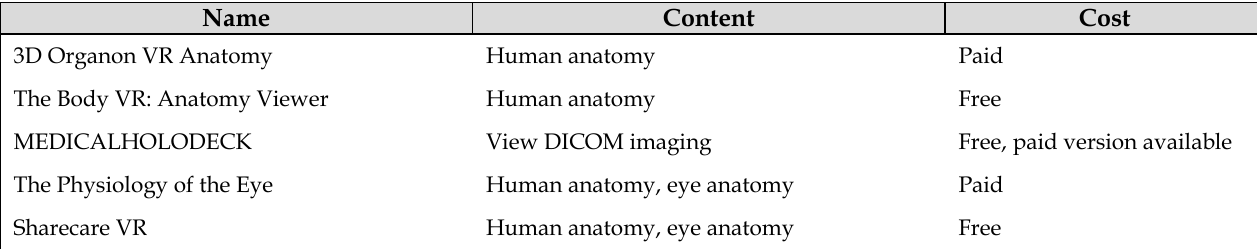
Table 1 Anatomy and health sciences–related software available for the HTC VIVE Pro [15]